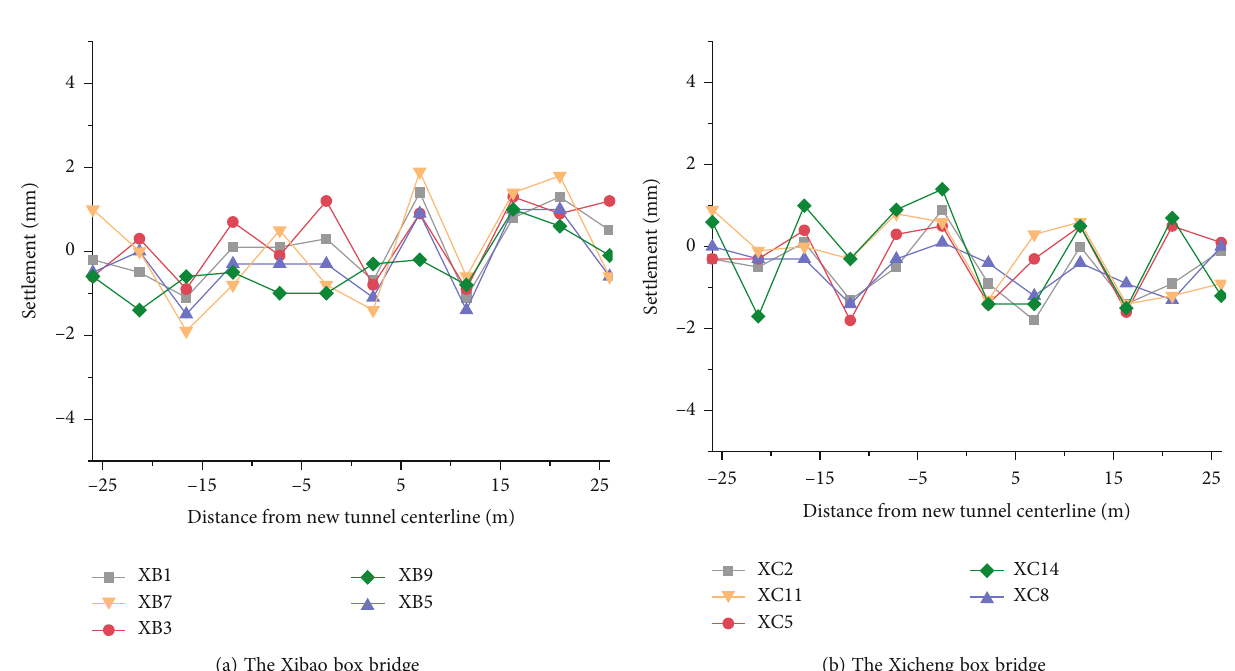
Figure 13: The settlement curve of the box bridge